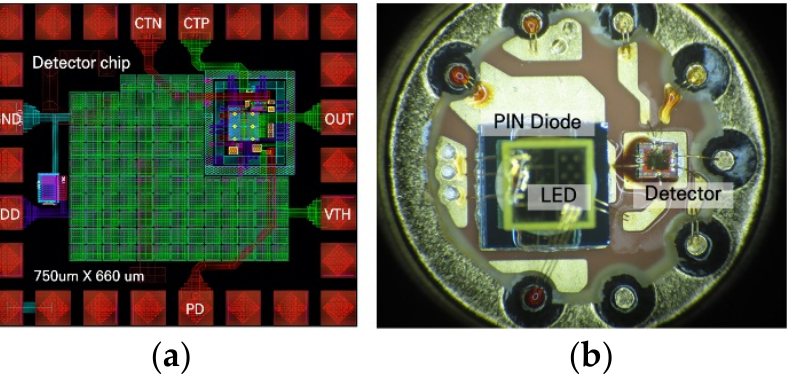
Figure 11. Proposed pulsed-radiation detection circuit: ( a ) 0.18 um CMOS bulk process layout drawing, ( b ) photograph of the inner part of the package chip that contains the test light-emitting diode and PIN diode.